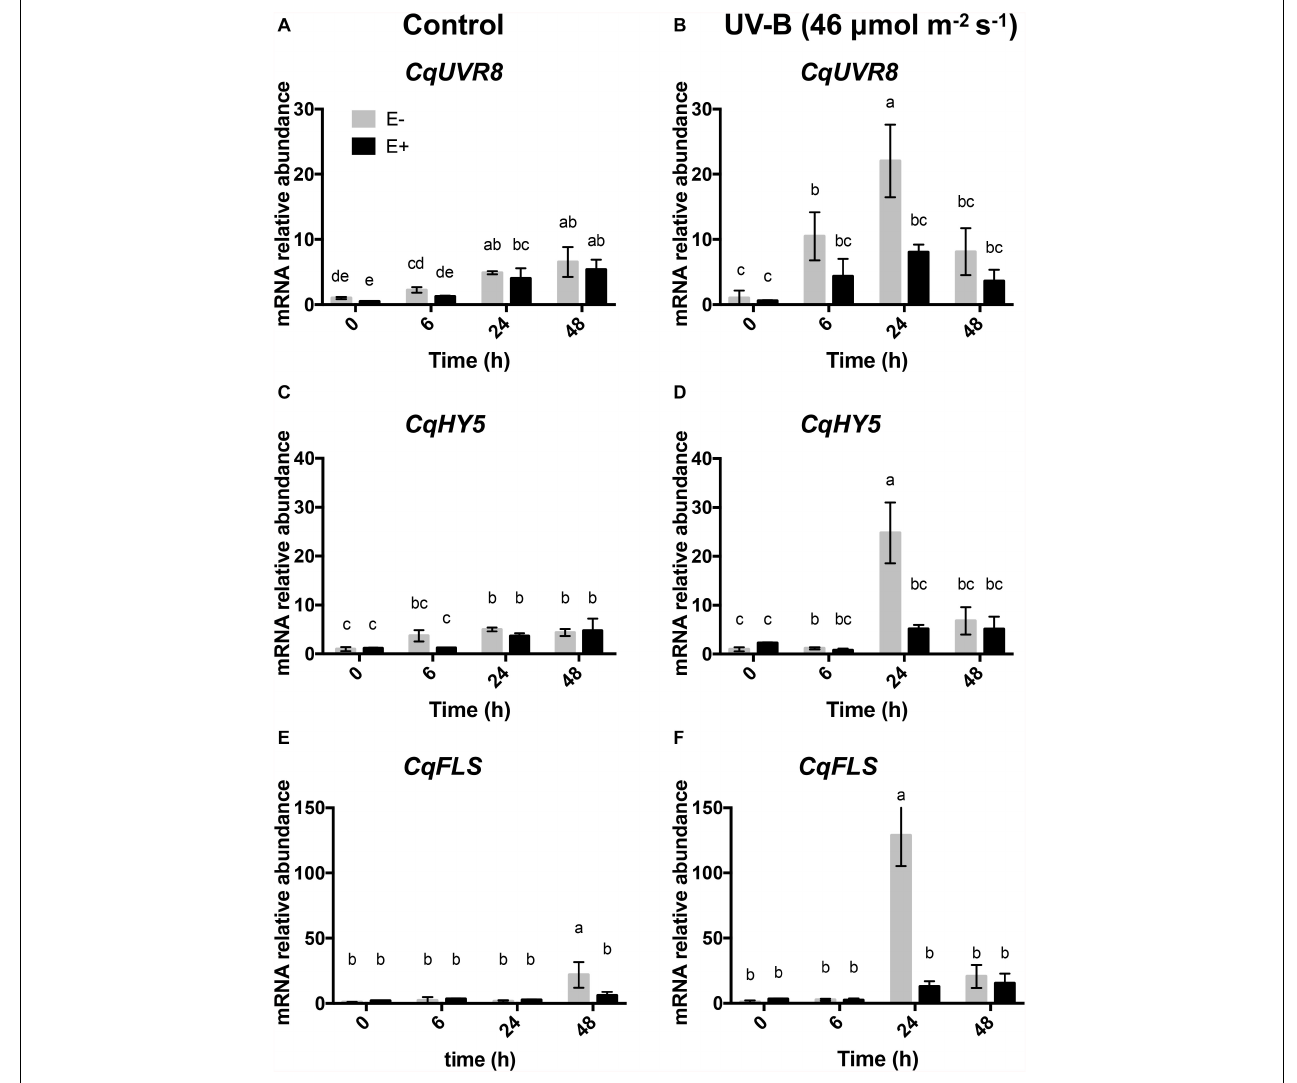
FIGURE 3 | Transcript profile of genes in response to UV-B treatment in the leaves of C. quitensis . Transcript levels of UVR8 , HY5 , and FLS were evaluated in plants exposed to control [without radiation UV-B radiation (A,C,E) ] and with UV-B [46 ( µ mol m − 2 s − 1 (B,D,F) ] radiation and with and without endophytes (E+ and E–). For relative transcript levels, normalization was performed against housekeeping genes ( α -tubulin and β -tubulin) in all samples. Different letters indicate significant differences ( P < 0.05; two-way ANOVA). Bars represent the means ± SE of three independent